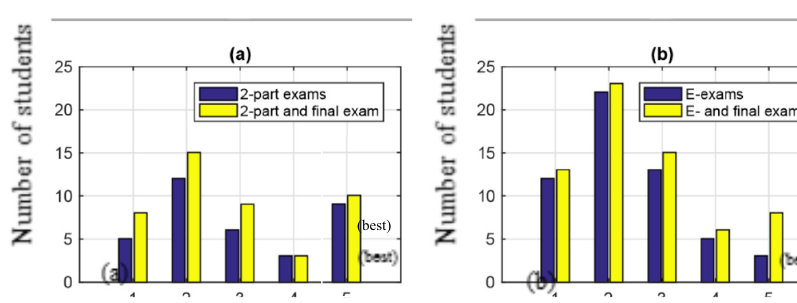
Fig. 2. The Grade histograms of the passed students in a) 2016 and b)